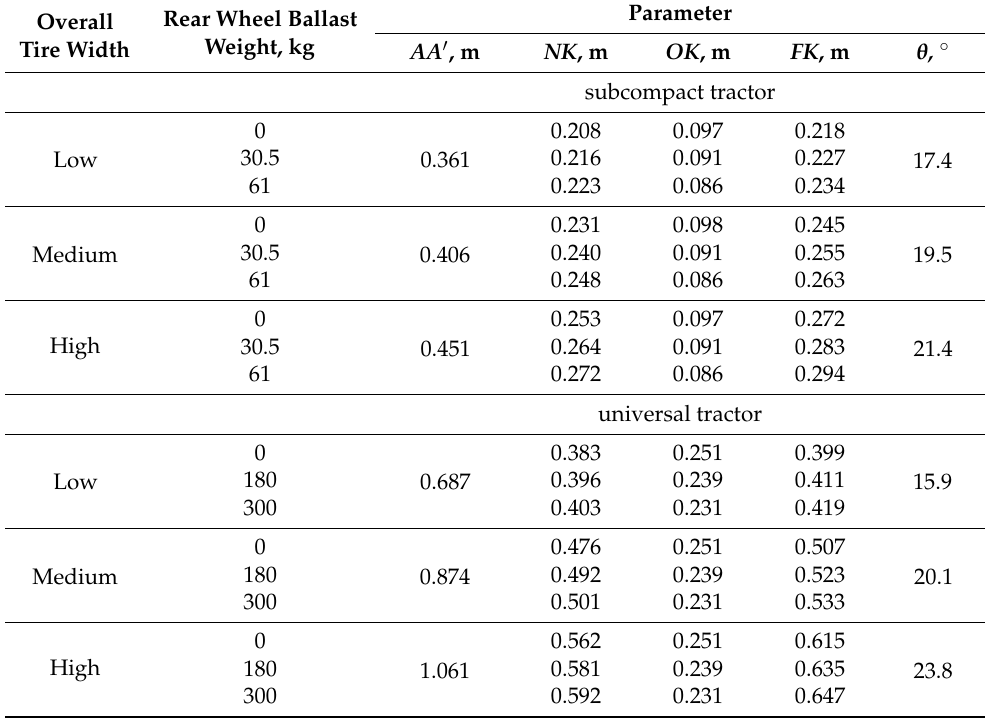
Table 3. Design features of proposed calculation